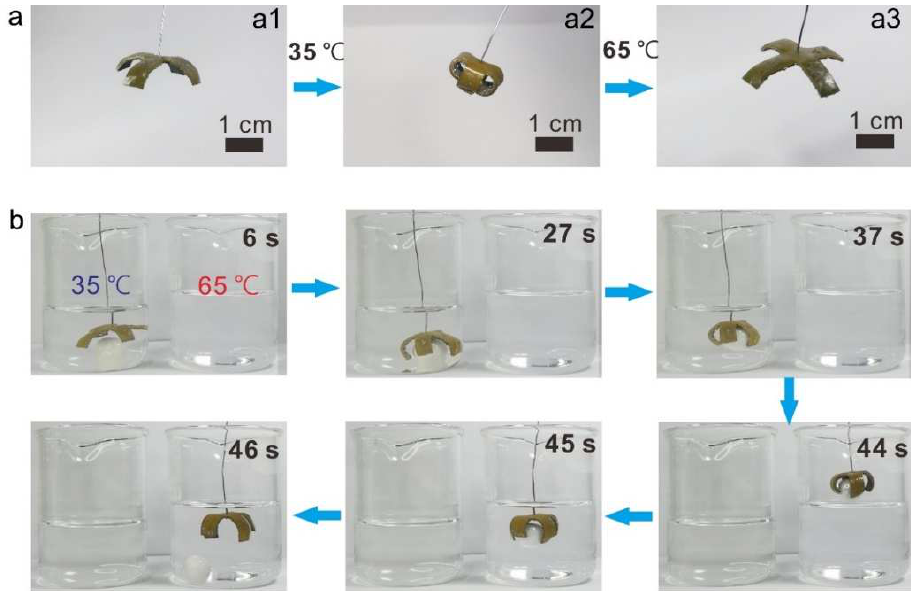
Figure 3. A soft gripper fabricated with the Ga–PU composite (20 vol% Ga). ( a ) The programed gripper undergoes shape change in response to temperature variation. ( b ) The gripper grasps and transfers an object.